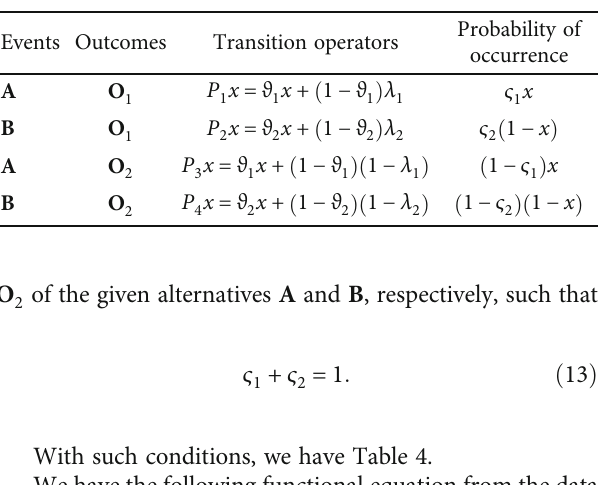
Table 4: Four events under conditional probabilities of